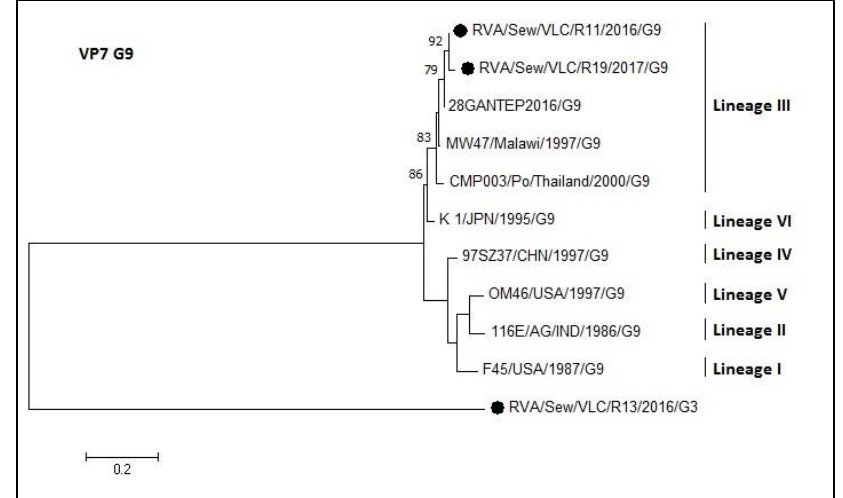
Figure 8. Molecular phylogenetic analysis of G9 rotavirus (VP7 gene). The evolutionary history was inferred by using the Maximum Likelihood method based on the Tamura 3-parameter model [43] with a bootstrap of 1000 replicates. The tree is drawn to scale, the branch lengths measure the number of substitutions per site. The analysis included 11 nucleotide sequences. There was a total of 159 positions in the final dataset including nucleotides from 774 to 933.